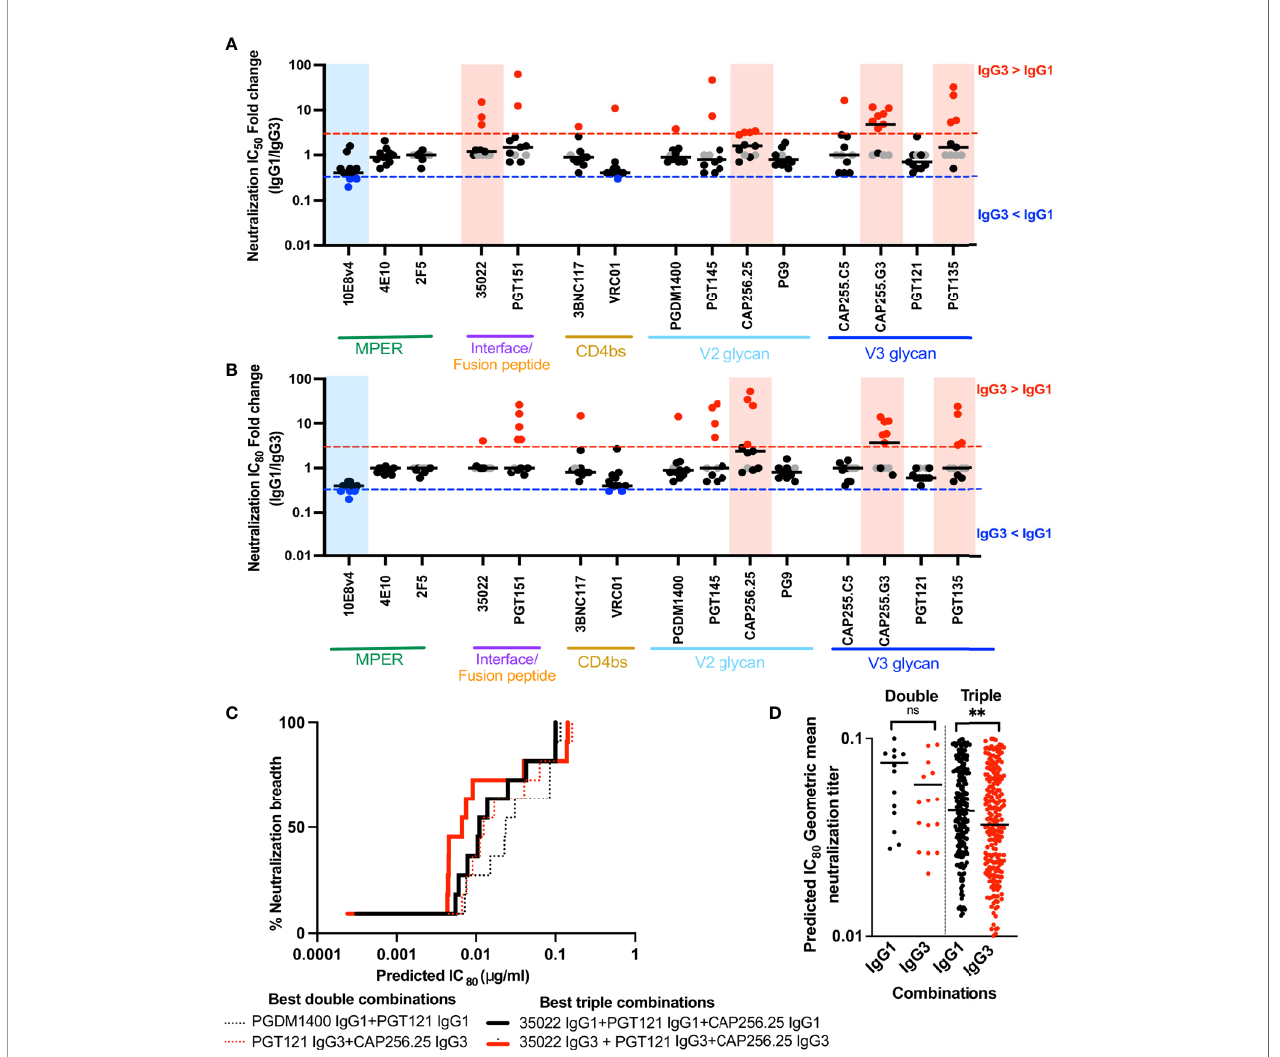
FIGURE 4 | IgG3 bNAb variants enhance or maintain neutralization of a multiclade panel of viruses and IgG3 combinations are are more potent that IgG1 combinations. (A) Fold changes of IC 50 and (B) IC 80 between IgG3 and IgG1 bNAb variants, by epitope targets against 11 viruses from the multiclade global panel where the neutralization is represented by individual dots. The red and blue lines indicate 3 fold difference where IgG3 > IgG1 and IgG3 < IgG1 respectively. Grey dots indicate instances where a virus is resistance to neutralization and shaded blue and red areas indicating those instances where there is a statistically signi fi cant difference between IgG1 and IgG3 activity against all viruses, for that bNAb pair. (C) Neutralization breadth potency curves of the best double (dotted) and triple (bold) combinations of antibodies as de fi ned by the Bliss-Hill model. IgG1 in black, IgG3 in red. (D) All double or triple combinations of antibodies that show 100% breadth against the 11 virus panel are shown as the predicted IC 80 geomean titers. ** denotes p < 0.01 and ns denotes non-signi fi cant, Mann-Whitney t